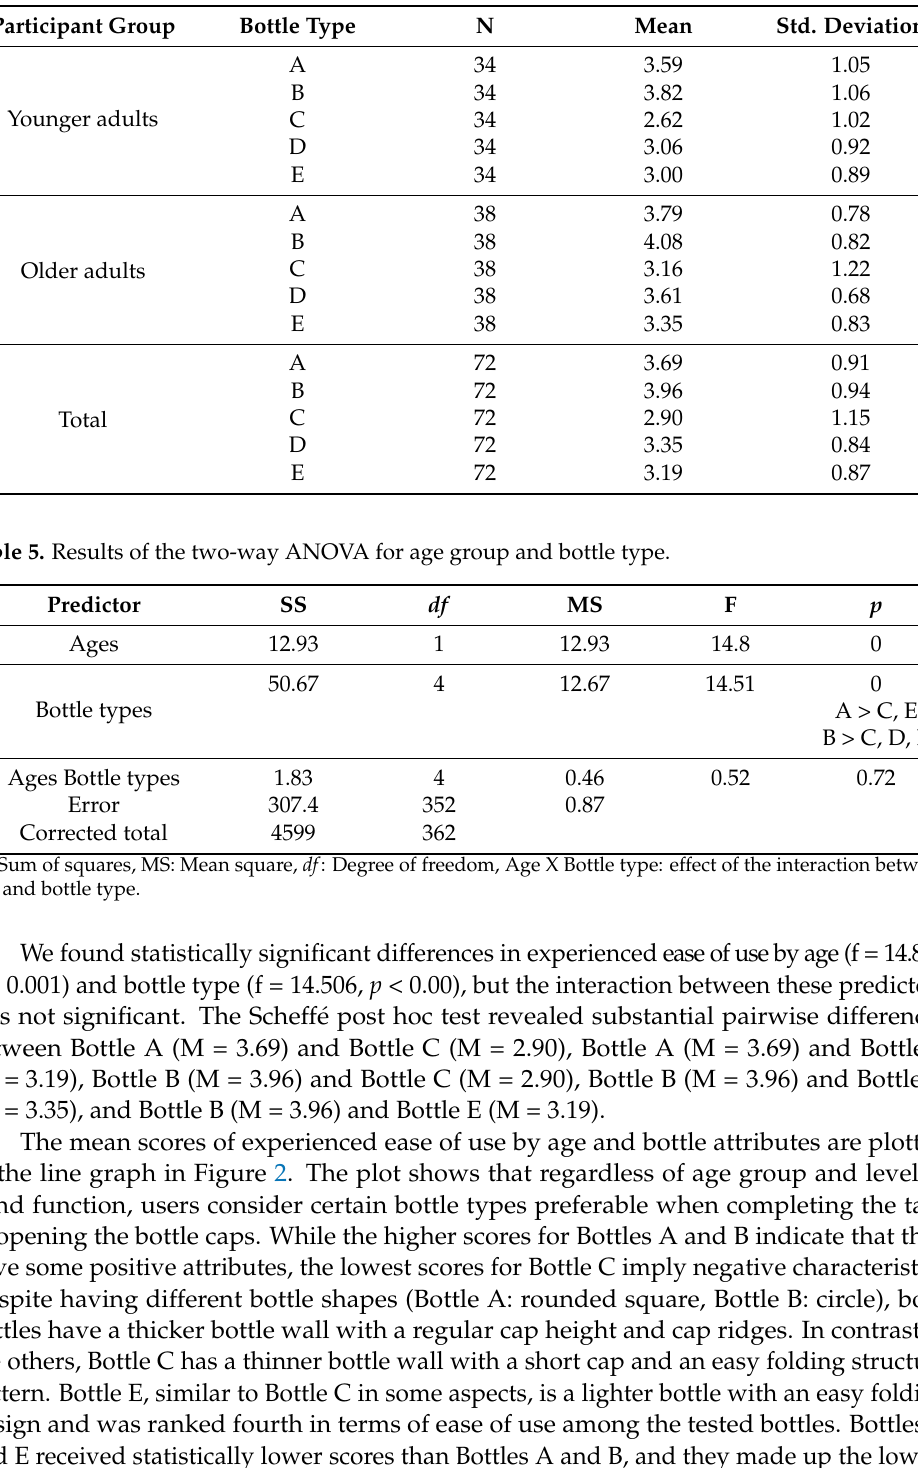
Table 4. Descriptive statistics for participant group and bottle type.